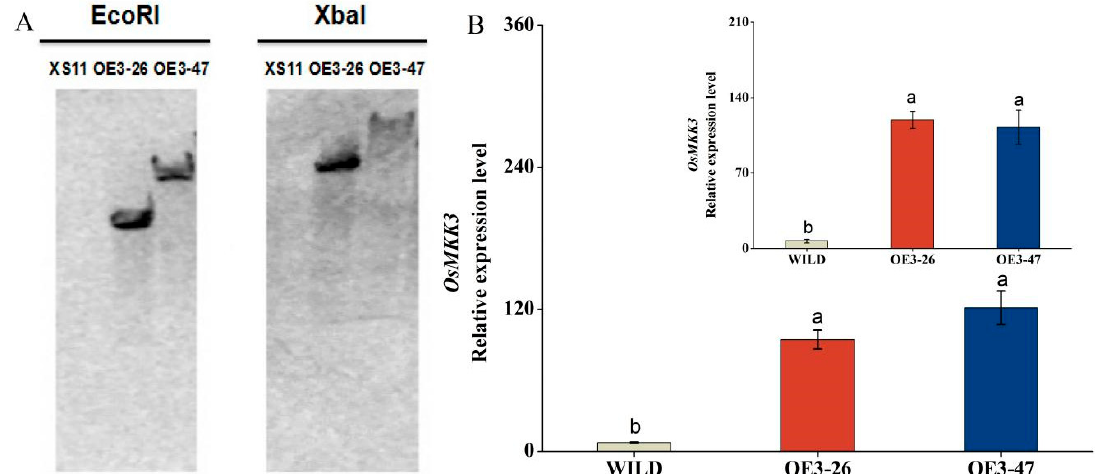
Figure 2. Southern blotting and OMKK3 expression levels in oe-MKK3 (OE3-26, 47) and wild-type plants (WILD). ( A ) The DNA-hybridized band of oe-MKK3 meant a single insertion by southern blotting. ( B ) OsMKK3 expression levels (mean ± SE, n = 5) in oe-MKK3 and WILD without wounding treatment were analyzed by qRT-PCR, and the insertion represented OsMKK3 expression levels in oe-MKK3 and WILD at 8 h after wounding. Different letters represent significant differences among oe-MKK3 and wild-type plants (Duncan’s multiple range test, p < 0.05). oe-MKK3: transgenic lines which overexpressed OMKK3 .